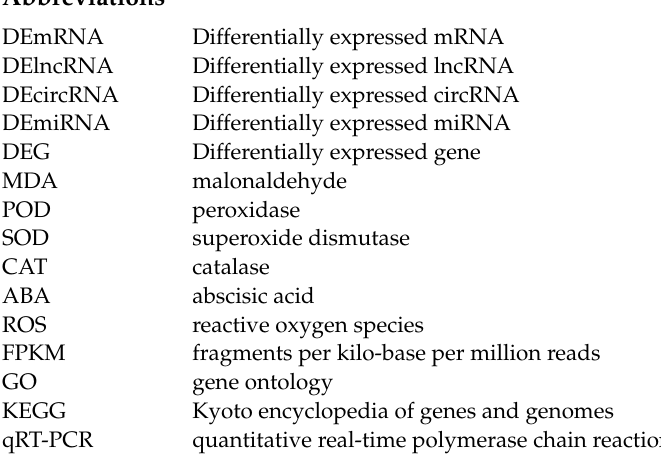
Table S2: Details information of identified lncRNAs, Table S3: Target Prediction of DElncRNA in roots, Table S4: Details information of identified circRNAs, Table S5: Details information of identified miRNAs (known and novel), Table S6: Details information of DEmiRNAs, Table S7: Target Prediction of miRNA by bioinformatics, Table S8: Target identified of miRNAs by degradome sequencing, Table S9: List of primers used for qRT-PCR experiments, Figure S1: Mapman analysis of DEmRNAs in leaves (a–d) and roots (e–h) under salt stress, Figure S2: GO and KEGG enrichment analysis of DEmRNAs targets, Figure S3: Sampling